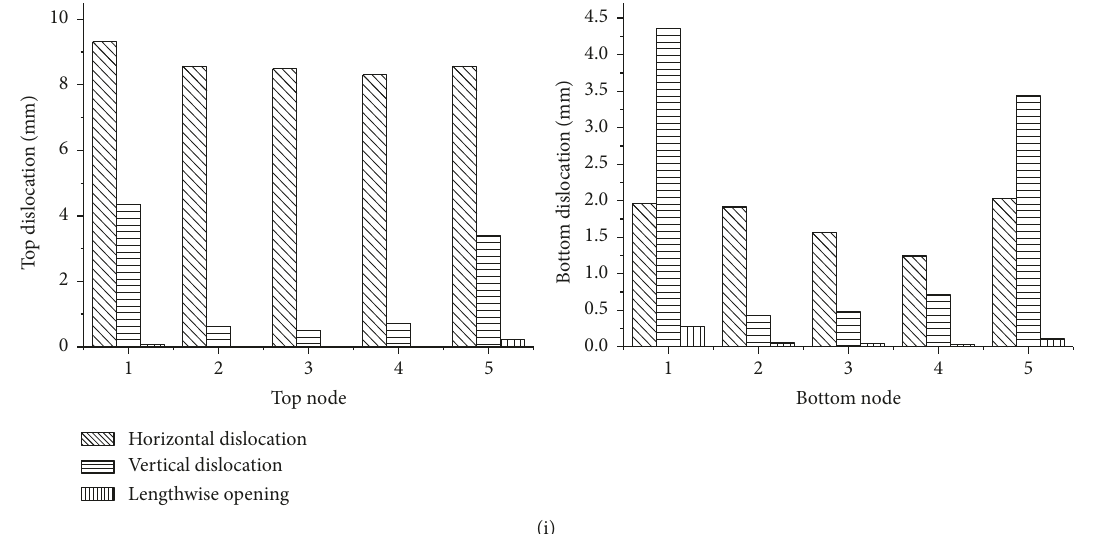
Figure 10: Joint dislocation (opening) at different angles of incidence. (a) Dislocation (opening) of roof and floor at pipe joints under incident angle (0 ° , 0 ° ); (b) dislocation (opening) of roof and floor at pipe joints under incident angle (0 ° , 15 ° ); (c) dislocation (opening) of roof and floor at pipe joints under incident angle (0 ° , 30 ° ); (d) dislocation (opening) of roof and floor at pipe joints under incident angle (30 ° , 0 ° ); (e) dislocation (opening) of roof and floor at pipe joints under incident angle (30 ° , 15 ° ); (f) dislocation (opening) of roof and floor at pipe joints under incident angle (30 ° , 30 ° ); (g) dislocation (opening) of roof and floor at pipe joints under incident angle (60 ° , 0 ° ); (h) dislocation (opening) of roof and floor at pipe joints under incident angle (60 ° , 15 ° ); and (i) dislocation (opening) of roof and floor at pipe joints under incident angle (60 ° , 30 °